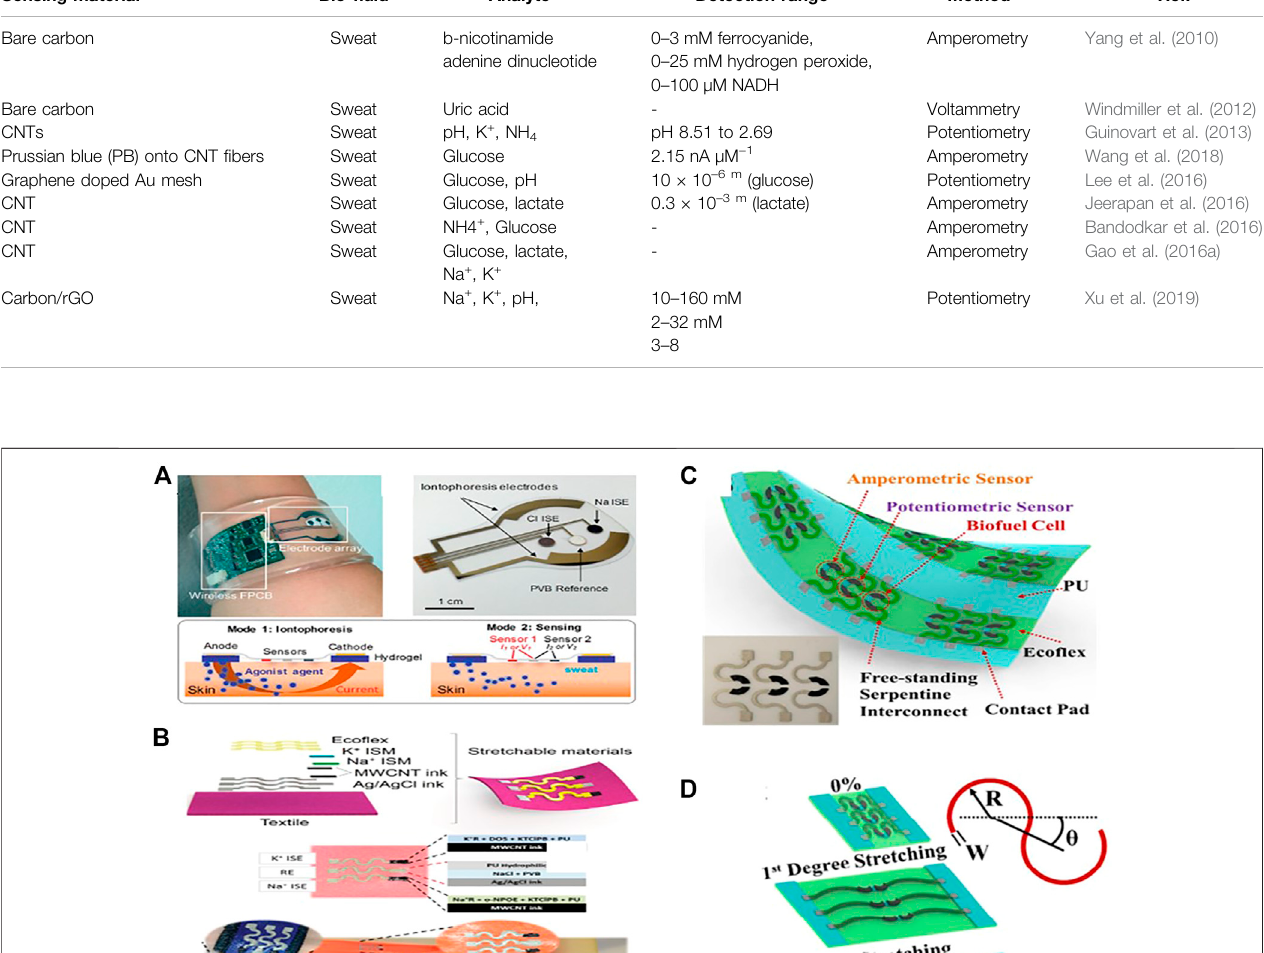
TABLE 2 | Carbon based nanomaterials in electrochemical biosensors. Sensing material